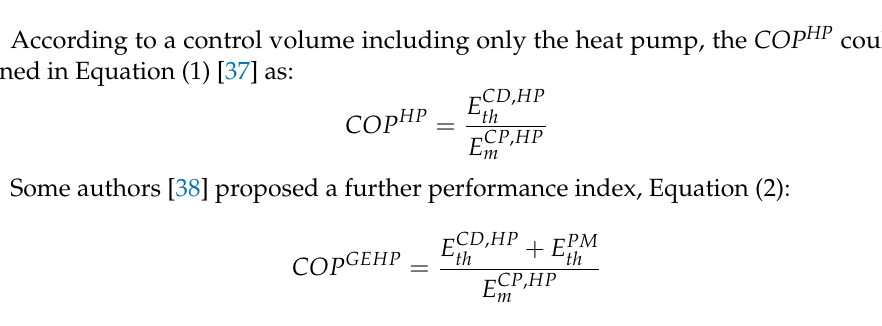
Figure 10. GEHP in heating operating mode with direct engine heat recovery.